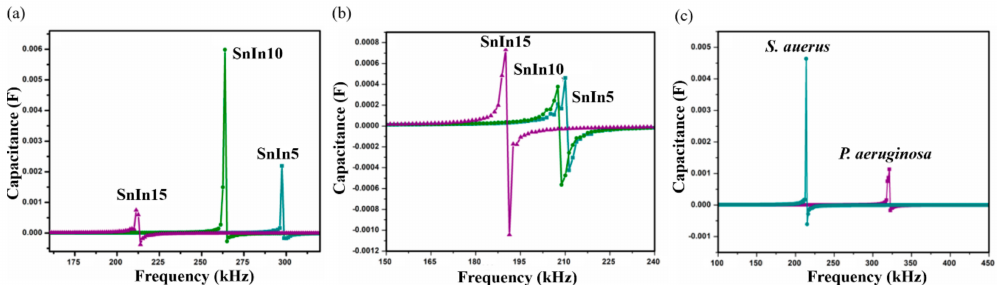
Figure 7. ( a ) SRF observed from P. aeruginosa , ( b ) SRF observed from S. aureus using SnIn5, SnIn10 and SnIn15 samples, and ( c ) comparison of obtained SRF values from S. aureus and P. aeruginosa , for sample SnIn5.